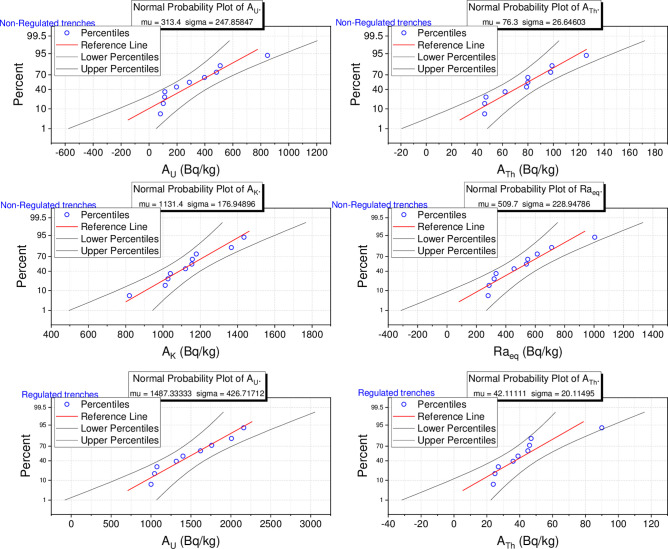
The normal probability of 238U, 232Th, and 40K activity concentrations for the studied non-regulated and regulated trenches.